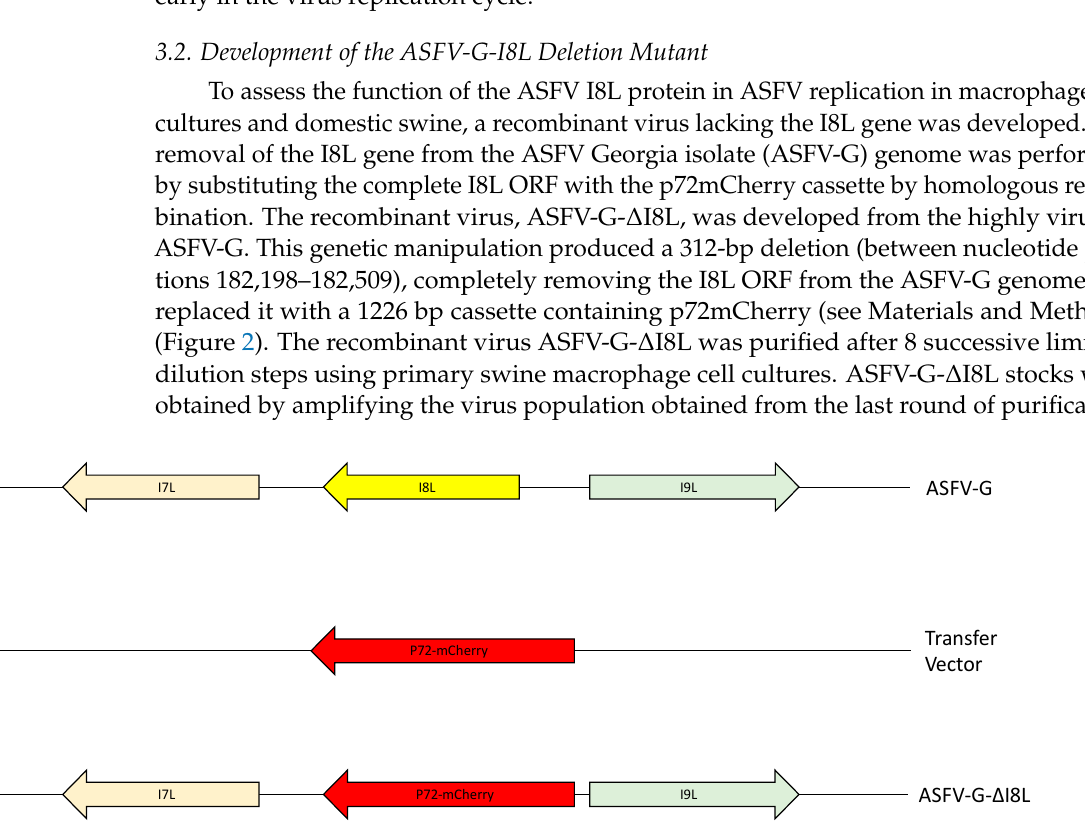
Figure 2. Schematic for the development of ASFV-G- Δ I8L. The transfer vector contains p72 promoter and the mCherry cassette, along with the flanking left and right arms of the transfer vector, designed to have flanking ends to both sides of the deletion/insertion cassette. The resulting ASFV-G- Δ I8L with the cassette inserted is shown on the bottom; the inserted cassette is a direct replacement for the ORF I8L.